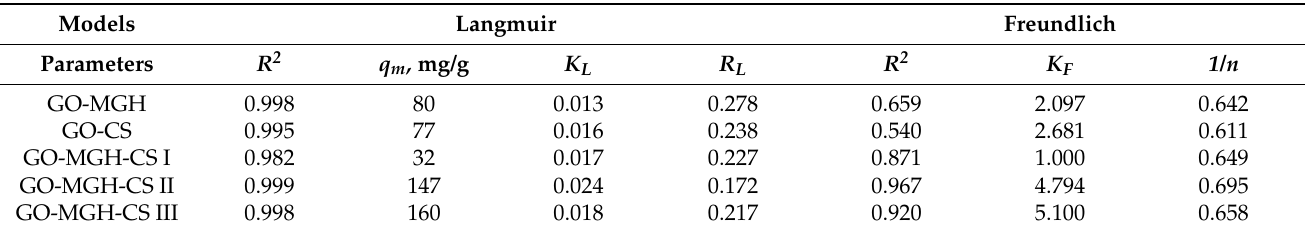
Figure 6. The non-linear adsorption isotherms of the Langmuir ( a ) and Freundlich ( b ). Table 2. The parameters of the isotherm